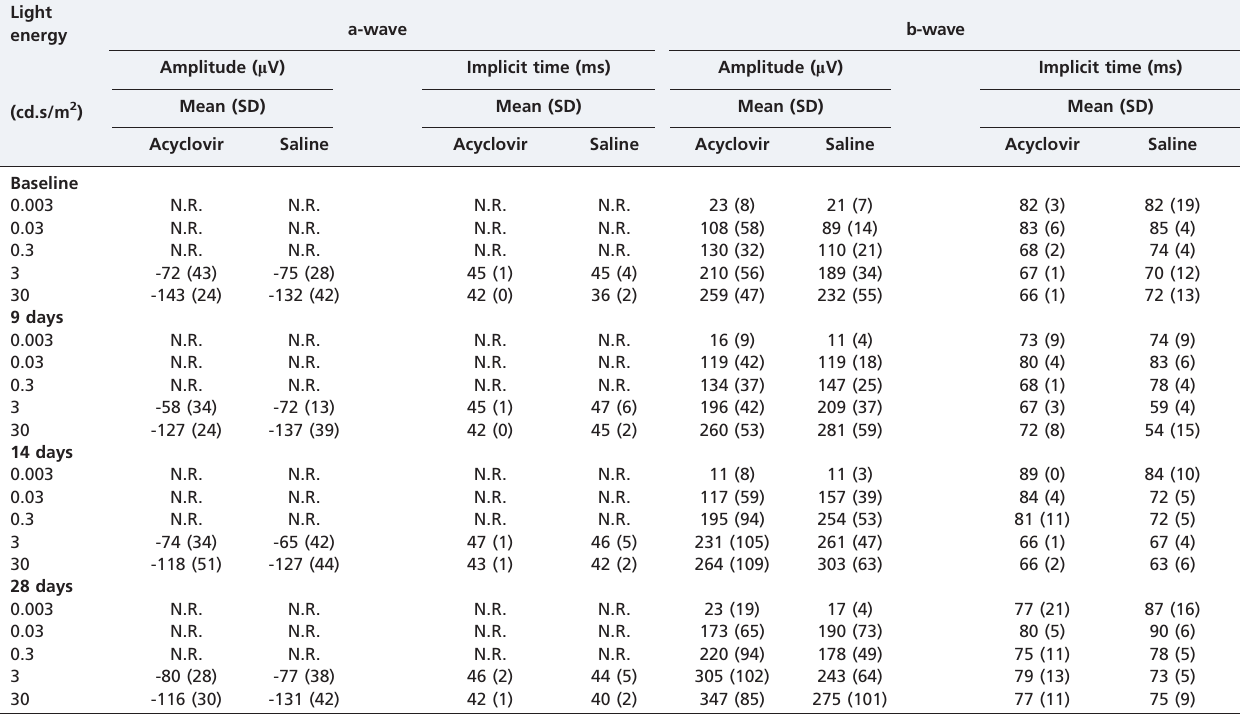
Table 1 - a- and b-wave amplitudes and implicit time means at different light intensities and time points (dark-adapted state). Eight animals were included at each time point. SD= standard deviation; N.R. = not registered.